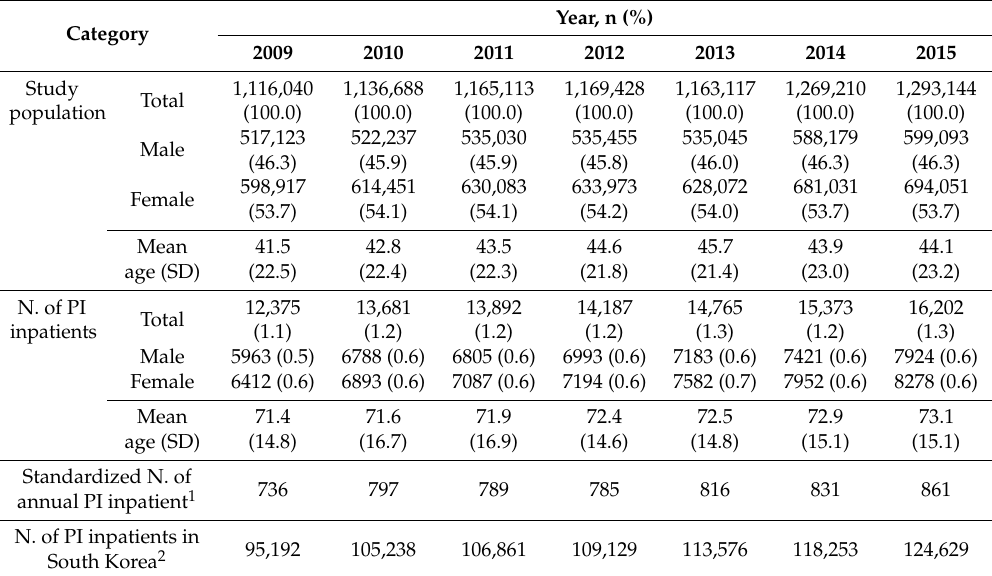
Table 1. Prevalence of PIs from 2009 to 2015 in South Korea.